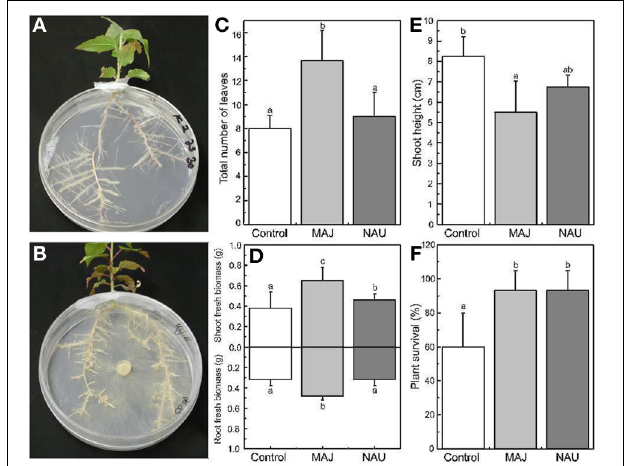
FIGURE 6 | Petri dish system for the cocultivation of Populus × canescens with P. involutus under axenic conditions. All data are shown for plantlets 4 weeks after the transfer into the Petri dishes. (A) Control, non-mycorrhizal plantlet, and (B) mycorrhizal plantlet. (C) Total leaf number, (D) shoot and root biomass, and (E) shoot height of plantlets inoculated with P. involutus strain MAJ or strain NAU (mean ± SD, n = 5). (F) Survival of non-inoculated control plantlets and plants inoculated with P. involutus strain MAJ or strain NAU (mean ± SD, n = 15). Different letters indicate significant differences with p < 0 .